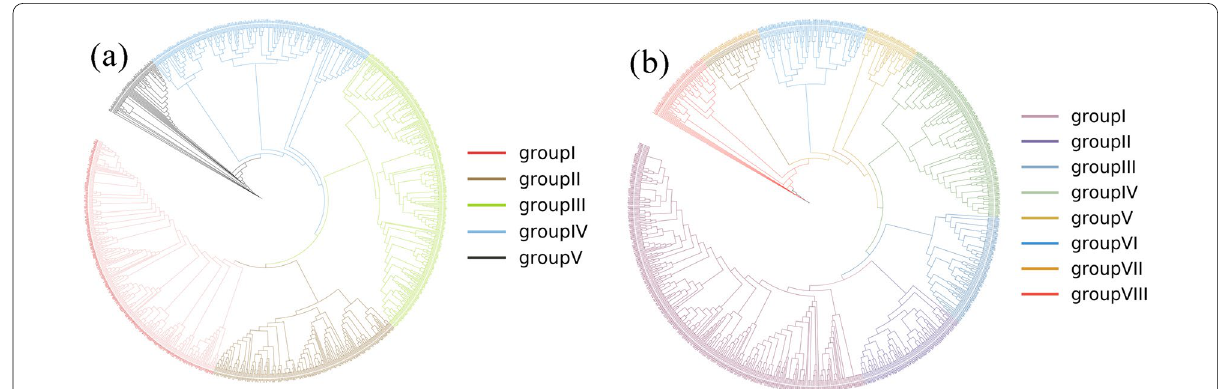
Fig. 1 The phylogenetic analysis of Rho members across 8 cotton species. a The phylogenetic tree of Rho members from 2 diploids of A genomes and 5 allotetraploids of A sub-genomes. b The phylogenetic tree of Rho members from 1 diploid of D genome and 5 allotetraploids of D